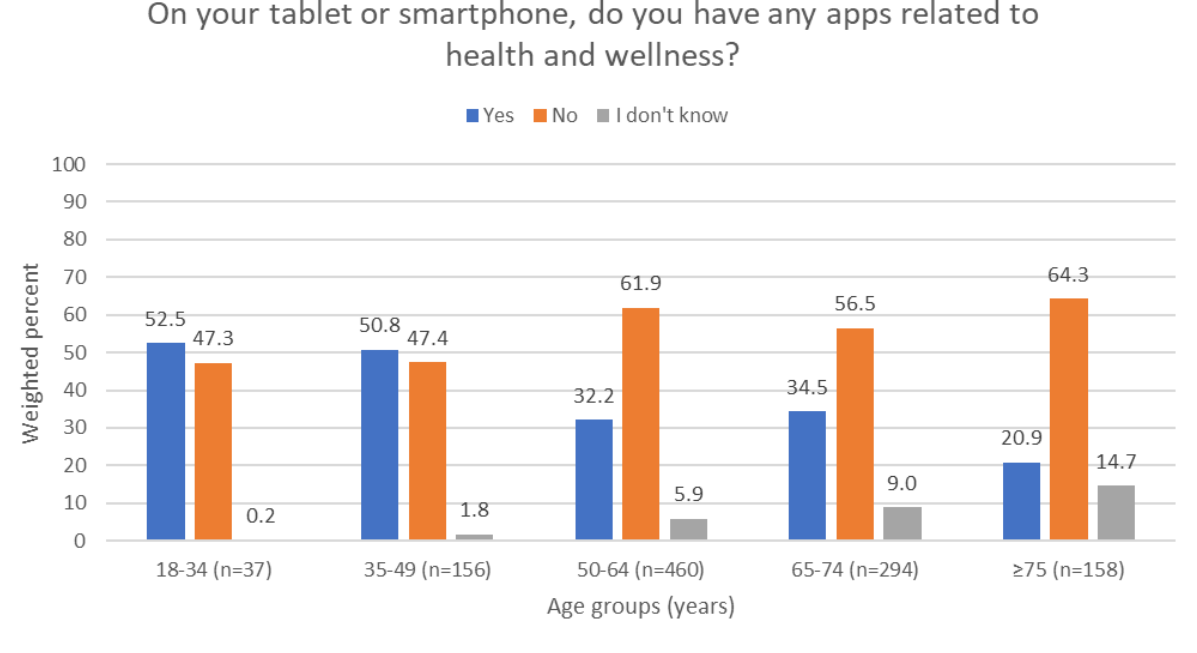
Figure 3. Among those with a self-reported history of hypertension exclusively, differences in health/wellness app use according to age. P=.001 for the test of whether the distribution of responses (“yes”, “no”, or “I don’t know”) differs by age group. Excludes those who answered “do not own a tablet or